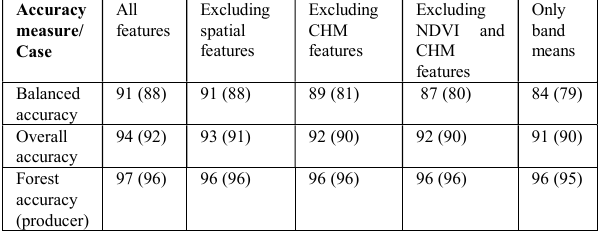
Table 5. The effects of including and excluding some features on the different measures of accuracy. Values for RF are the ones in the parentheses.